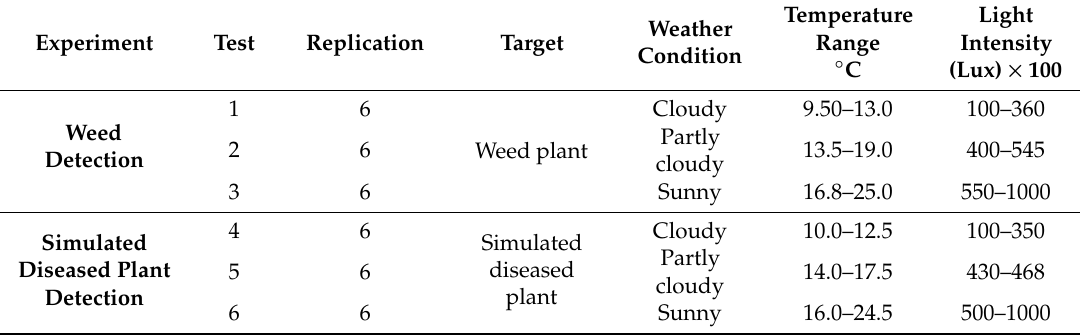
Table 2. Light intensity values at di ff erent weather conditions under which the sprayer was